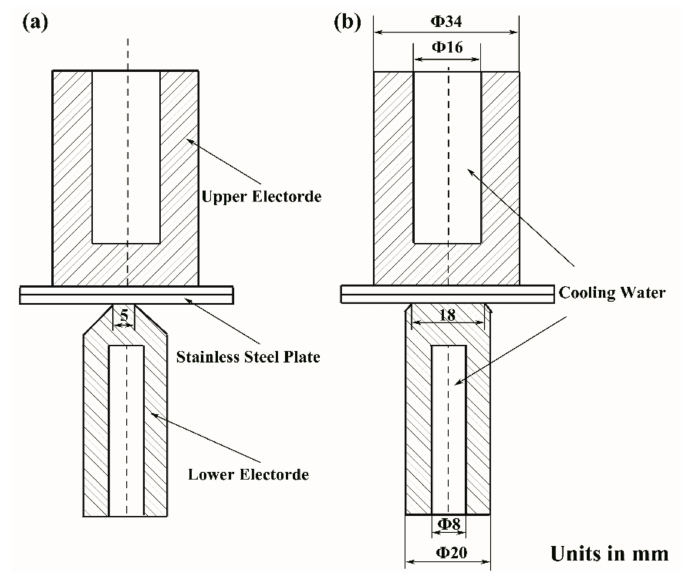
Figure 2. Dimensions of electrodes and the clamping method with workpieces: ( a ) the front view and ( b ) the side view.